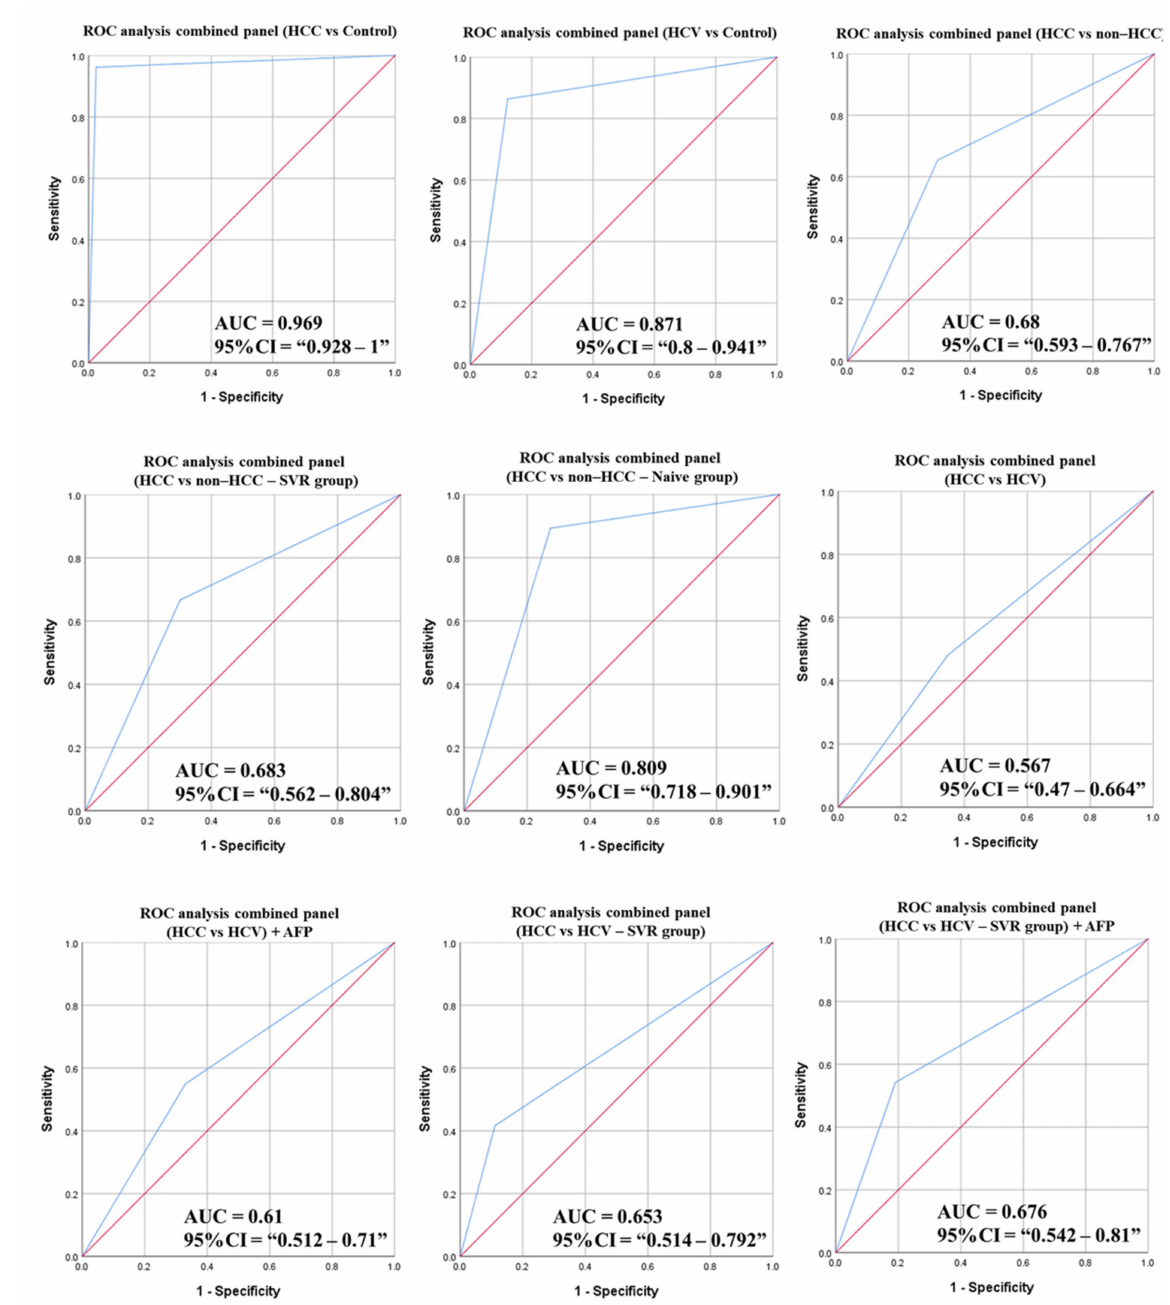
Figure 13. ROC curves and AUC for the combined panels of the DE-miRNAs among the study groups. (AFP: Alpha-fetoprotein, DE: Differentially expressed, HCC: Hepatocellular carcinoma, ROC: Receiver operating characteristic, SVR: Sustained virological